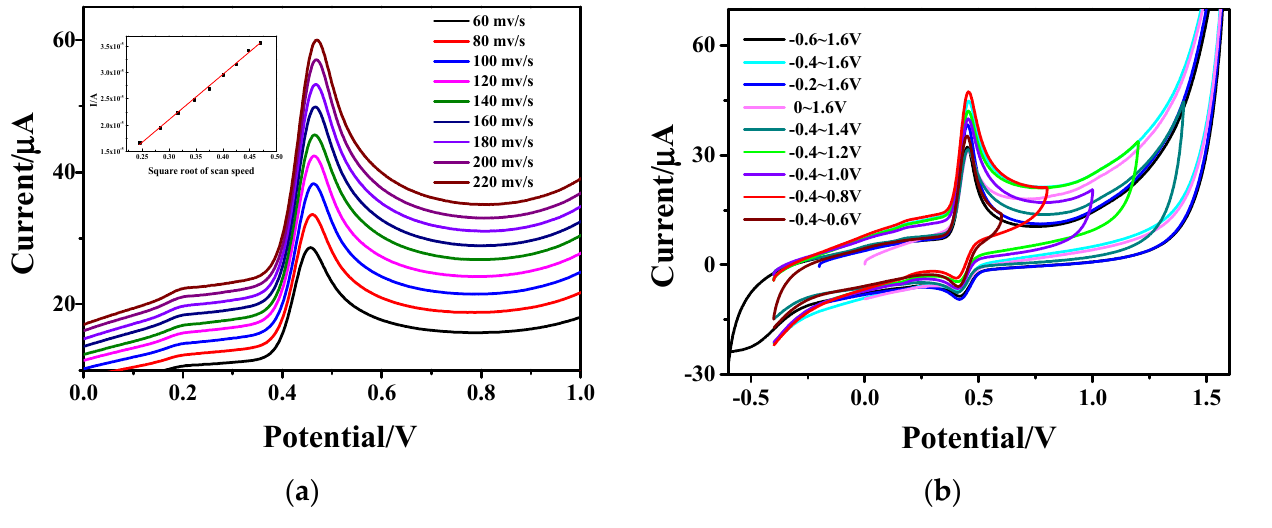
Figure 7. CV curves of Fe 3 O 4 -rGO/GCE electrode ( a ) at different scanning rates (the inset shows the linear relationship between the anodic peak currents of AC and the square root of the scanning rates ( √𝑣 )) and ( b ) in different scanning ranges.